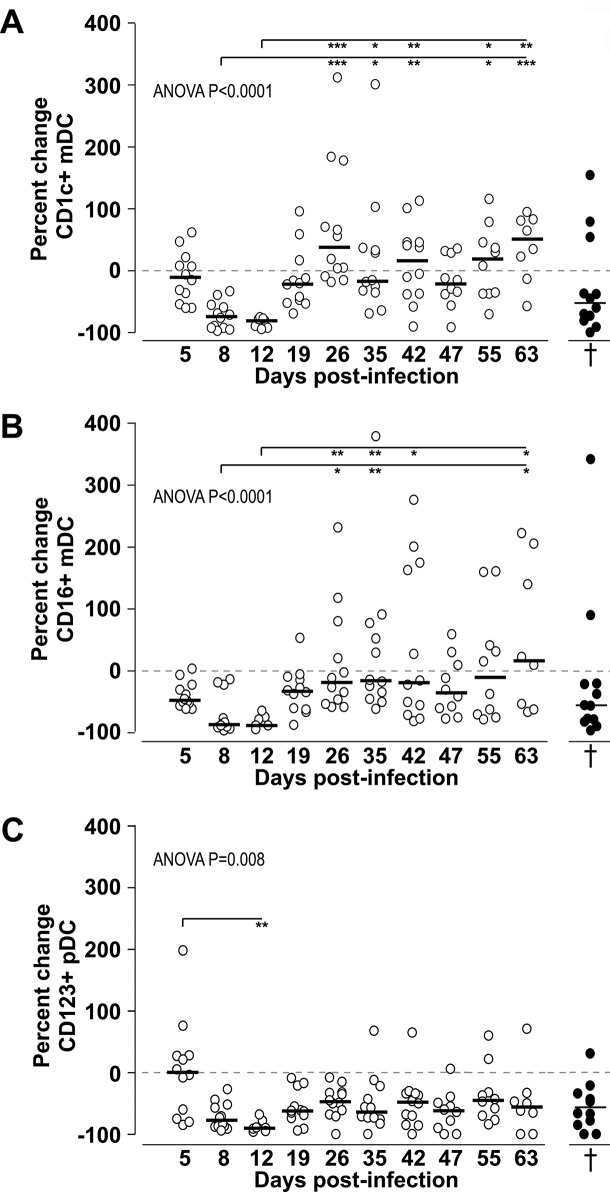
Longitudinal analyssis of the percentage change in absolute numbers of DCs in SIV infected CD8-lymphocyte depleted rhesus macaques.Percent changes in absolute numbers of CD1c+ mDCs (A), CD16+ mDCs (B) and CD123+ pDCs (C) were calculated at different time points post-infection by comparison to pre-infection (baseline: horizontal dashed line “0”). Negative percentages indicate cell loss while positive percentages represent a gain in circulating DCs. Percent changes measured at necropsy time (†) are shown as black symbols. Symbols represent individual animals and horizontal bars represent medians. The Kruskal-Wallis test followed by Dunn’s post test was used to determine the significance (asterisks) of differences in percent change absolute numbers during SIV infection. * P<0.05, ** P<0.01, *** P<0.001.